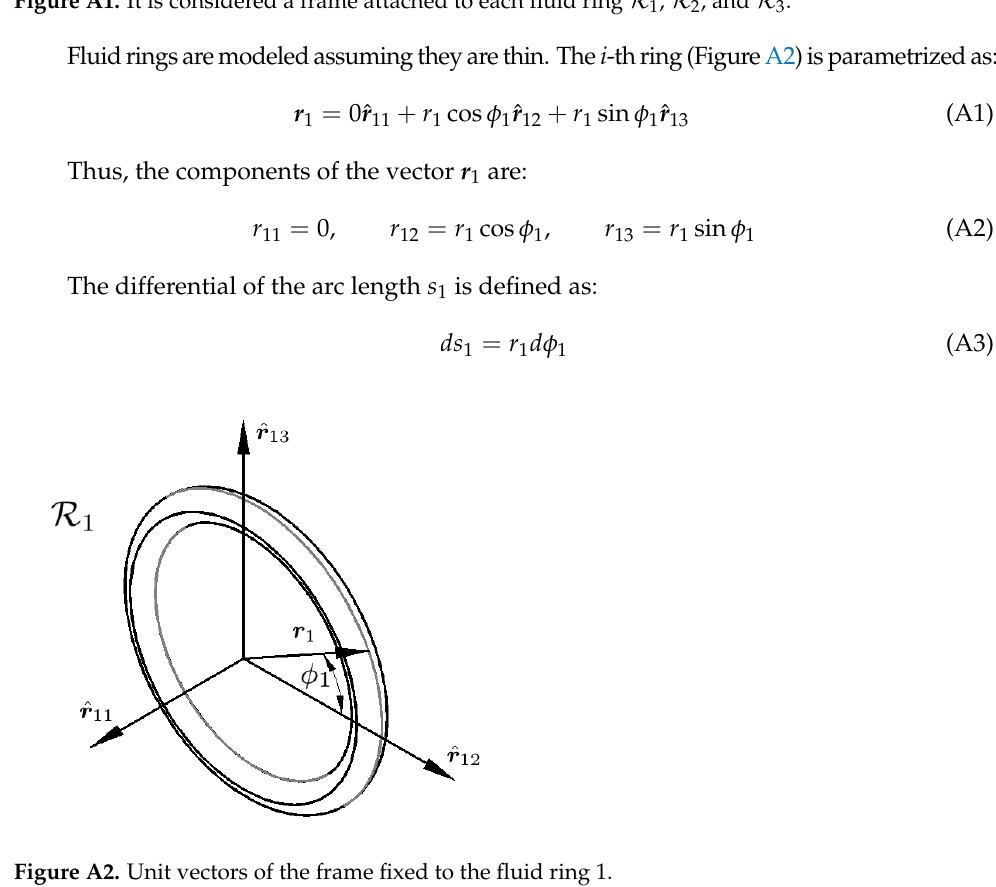
Figure A1. It is considered a frame attached to each fluid ring R 1 , R 2 , and R 3 .